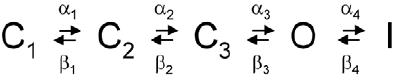
states (C 1 -C 3 ), an open state (O) and an inactivated state (I). Allowed transitions between states are indicated with arrows. The